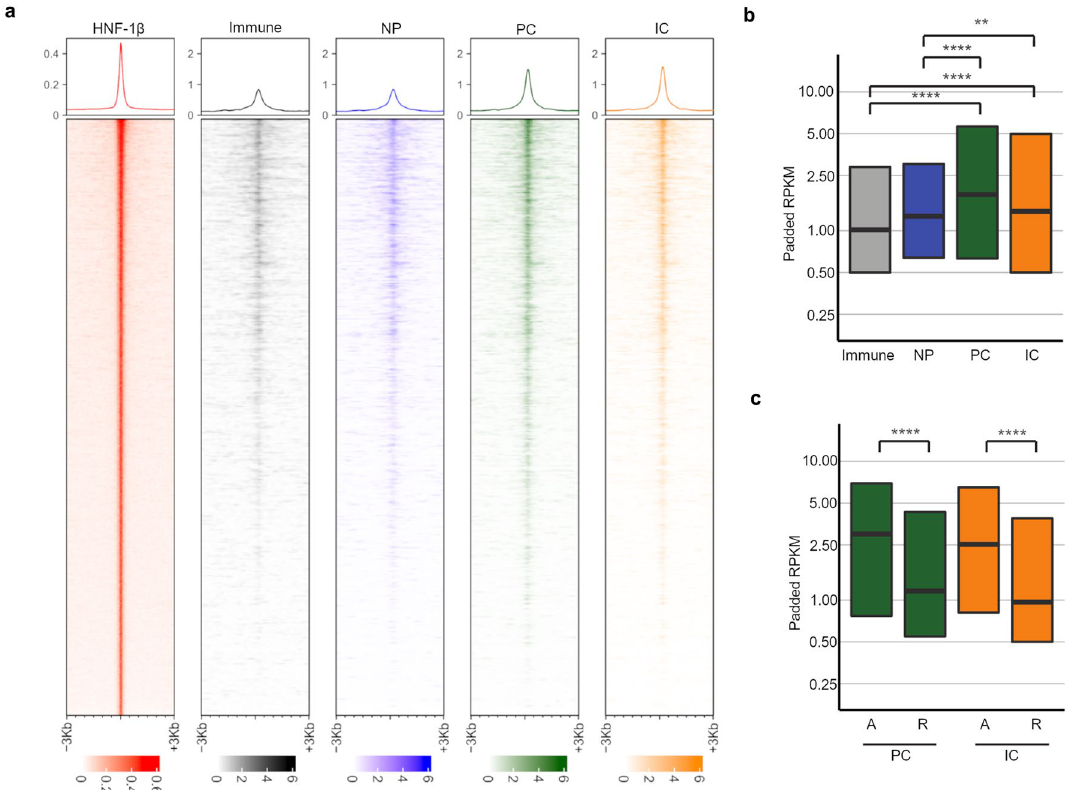
Figure 3. HNF-1β binding overlaps with regions of open chromatin in ureteric bud-derived cells. ( a ) Enrichment of single nuclear ATAC-seq (snATAC-seq) signal at sites of HNF-1β binding in chromatin from ureteric bud (UB)-derived principal cells (PC, green) and intercalated cells (IC, orange) in postnatal day (P)0 mouse kidneys. snATAC-seq in immune cells (gray) and nephron progenitors (NP, blue) is shown as a control. HNF-1β binding in UB cells is shown in red (left panel). Top panels show the total signal. ( b ) snATAC-seq enrichment at HNF-1β binding sites in immune cells, NP, PC, and IC shown in reads per kilobase of transcript (RPKM). Boxplots indicate the median and interquartile range. ( c ) snATAC-seq enrichment in PC and IC at HNF-1β binding sites near activated genes (A) and repressed genes (R). Asterisks indicate statistically significant differences using the Wilcoxon test (*p < 0.05; **p ≤ 0.01; ***p ≤ 0.001; ****p ≤ 0.0001). Median and mean enrichment values and individual Wilcoxon test results can be found in Supplementary Table